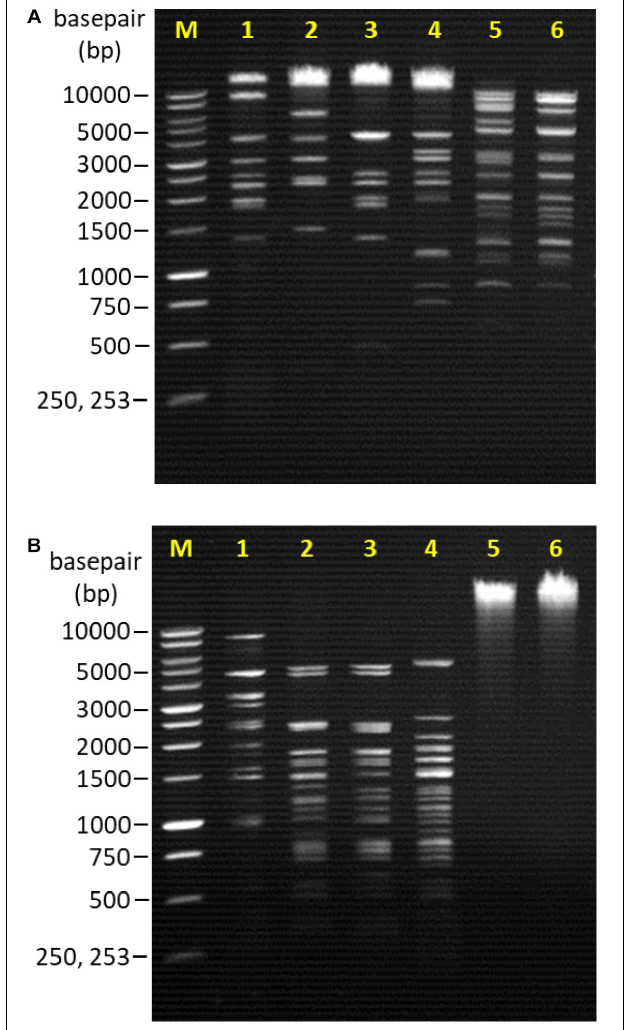
FIGURE 2 | Lane M: 1 kb DNA ladder (Promega, United States); Lane 1: Vp33; Lane 2: Vp22; Lane 3: Vp21; Lane 4: Vp02; Lane 5: Vp08; Lane 6: Vp11. (A) RFLP patterns of bacteriophages genomic DNA digested with Hin dIII. (B) RFLP patterns of bacteriophages genomic DNA digested with Hae